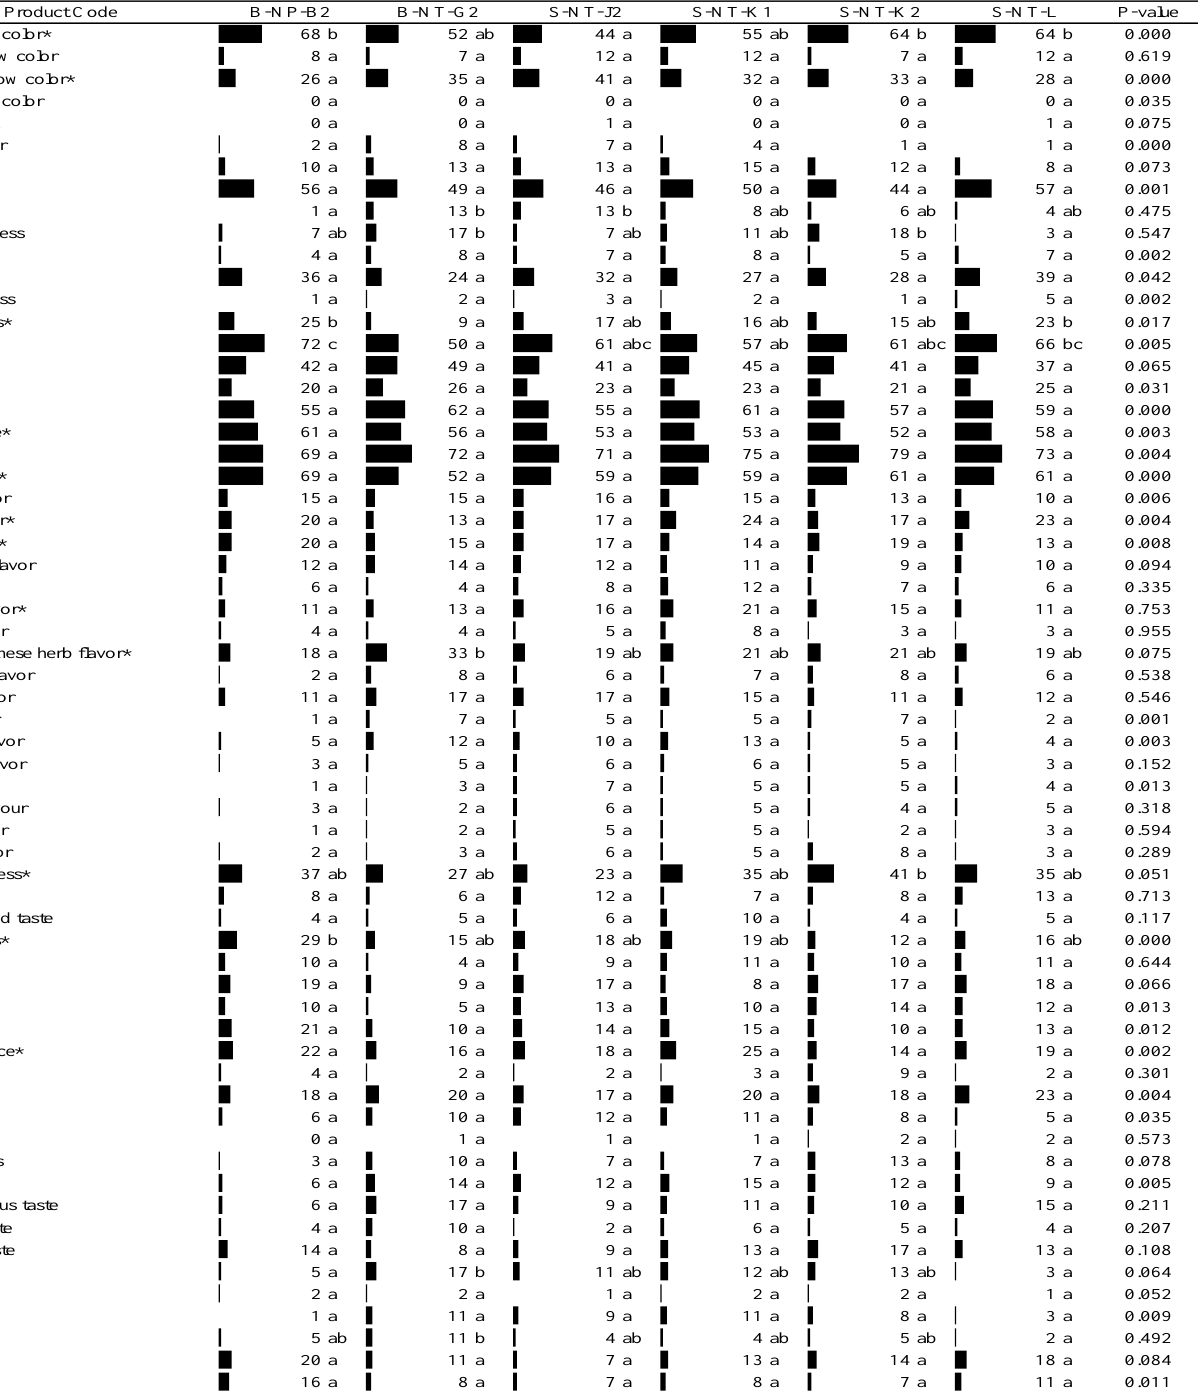
different in the frequencies of panelists’ selection for the attribute listed on the same row. Asterisks are marked on the attributes selected by more than 20% of respondents.